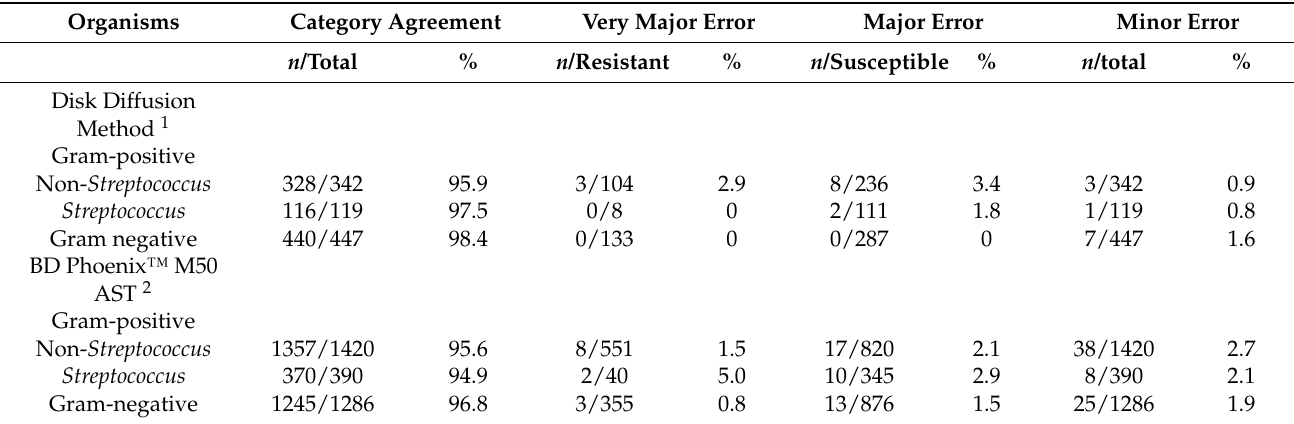
Table 6. High category agreements for Gram–positive and –negative bacteria were identified in the short-term incubation of disk diffusion method and the BD Phoenix™ M50 AST compared to the conventional overnight incubation method. Organisms Category Agreement Very Major Error Major Error Minor Error n